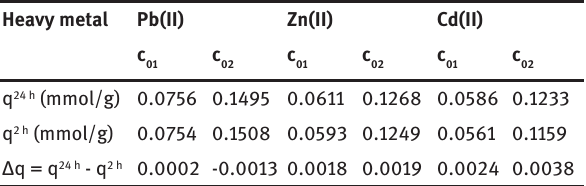
Table 2: Comparative values of q (mmol/g) obtained after 24 h (time required to reach maximum biosorption) and after 2 hours (time required to reach equilibrium).